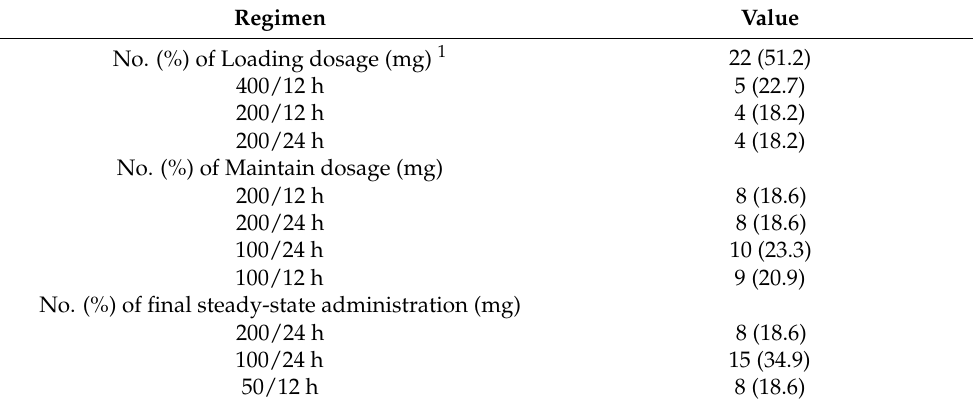
Table 2. Administration dosage of voriconazole in 43 CP-C patients 2